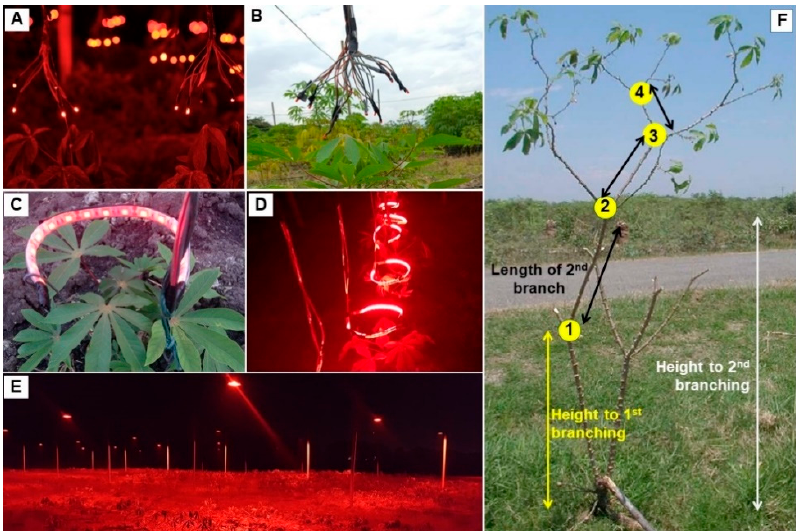
Figure 1. Illustration of the different sources of light emitting diode (LED) red lights used to extend the photoperiod in the different experiments reported in this study. ( A ): Five individual LEDs. ( B ): Ten individual LEDs. ( C ): One 20-cm LED tape. ( D ): Two 20-cm LED tapes. ( E ): The field illuminated with 50 W lamps with reflectors. ( F ): Illustration of a plant with four levels of branching (i.e., flowered four times during its growth). For height of first branch only one sprouted stem per plant was randomly considered as well as the branches above it.